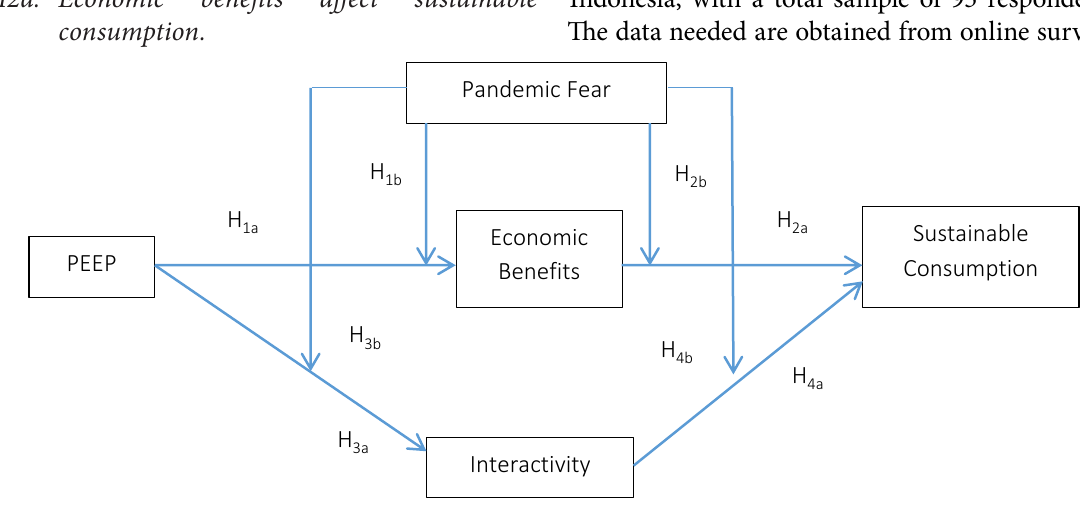
Figure 1. Conceptual